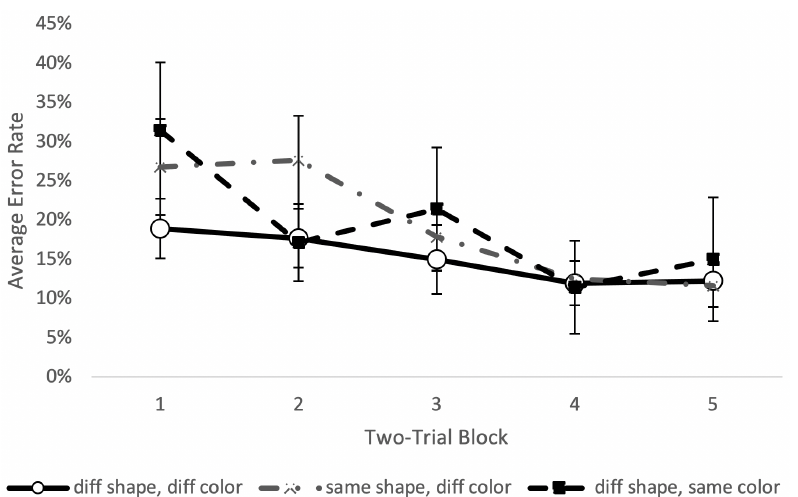
Figure 9. Mean error rate decreased significantly across trial blocks. Error rate was calculated by determining the number of errors divided by the number of trials of that type presented in the 53-trial session. There was no significant effect of trial type (F(2,12) = 1.22, p = 0.33, partial Eta 2 =